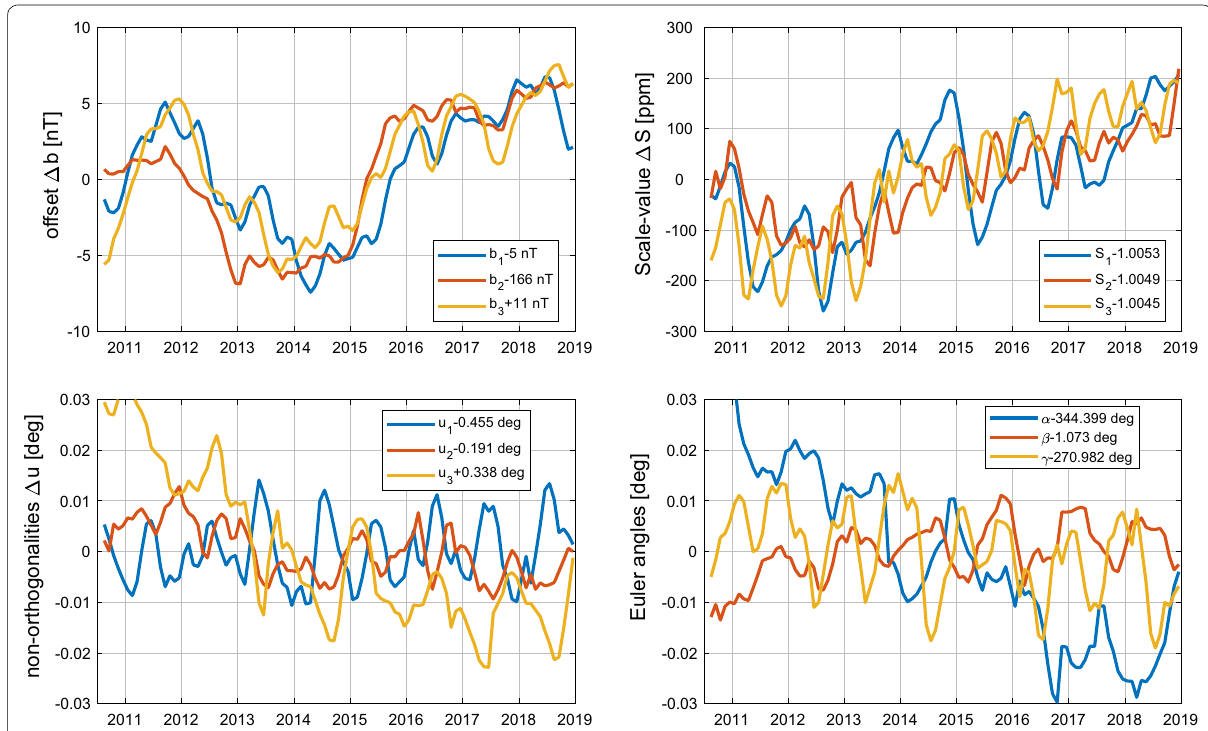
Fig. 3 Time dependence of the 12 “basic” calibration parameters for FGM1. Shown are deviations from their mean values as indicated in the figure